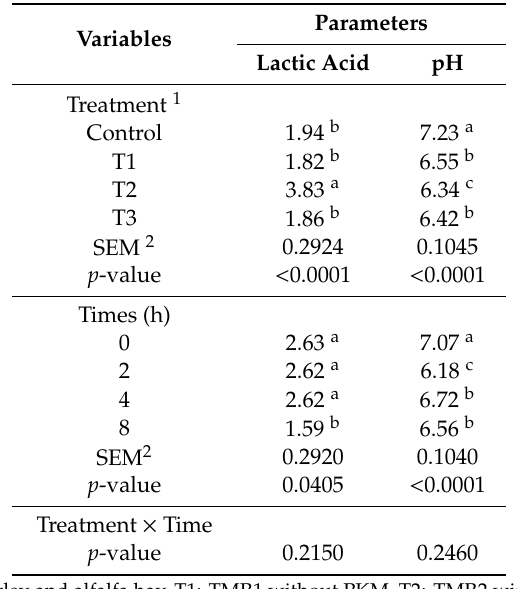
Table 3. E ff ect of treatments and times on lactic acid and pH in rumen fluid of the growing Naemi lambs at 42 days.